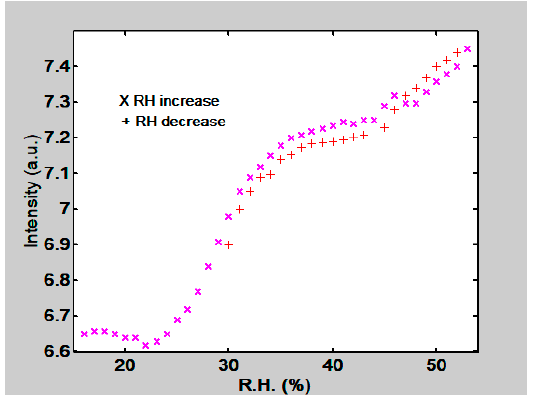
Figure 23. Behavior of first order intensity as a function of RH when it increases and decreases. Thin film thickness 15 µm.